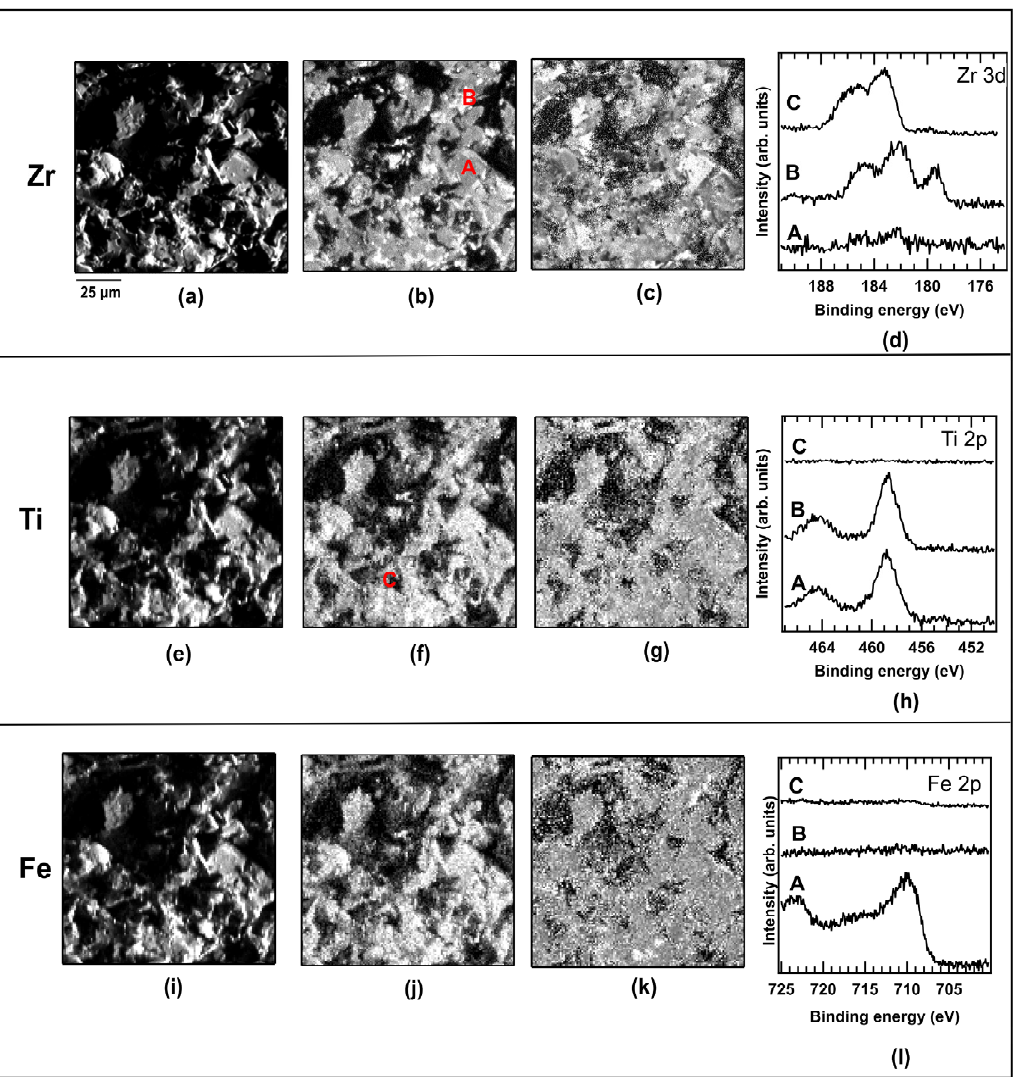
Figure 6. Element distribution and spectra of Ti, Fe and Zr in dehydrogenated TiFe + 4 wt.% Zr. Zr ( a – d ), Ti ( e – h ), Fe ( i – l ). Raw data: ( a , e , i ), Elemental distribution ( b , f , j ). Reduced/oxidized distribu- tion ( c , g , k ). Spectra ( d , h , l ).